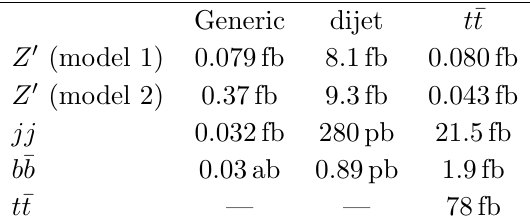
Table 4 . Signal and background cross sections for the Z 0 signal in scenario 2 and main SM backgrounds (in rows) under the three di(cid:11)erent event selections for generic, dijet, and t (cid:22) t resonance searches. The event selection for dijet and t (cid:22) t is the same as in scenario 1, and the quoted background numbers are the same as in table